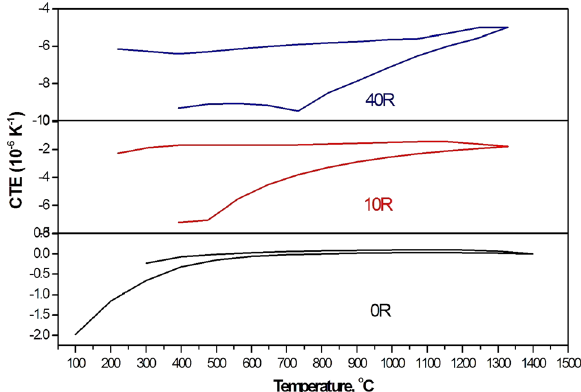
Figure 11. Heating/cooling curve of some selected A/ AT composites show the gradual change in the size of the formed hysteresis